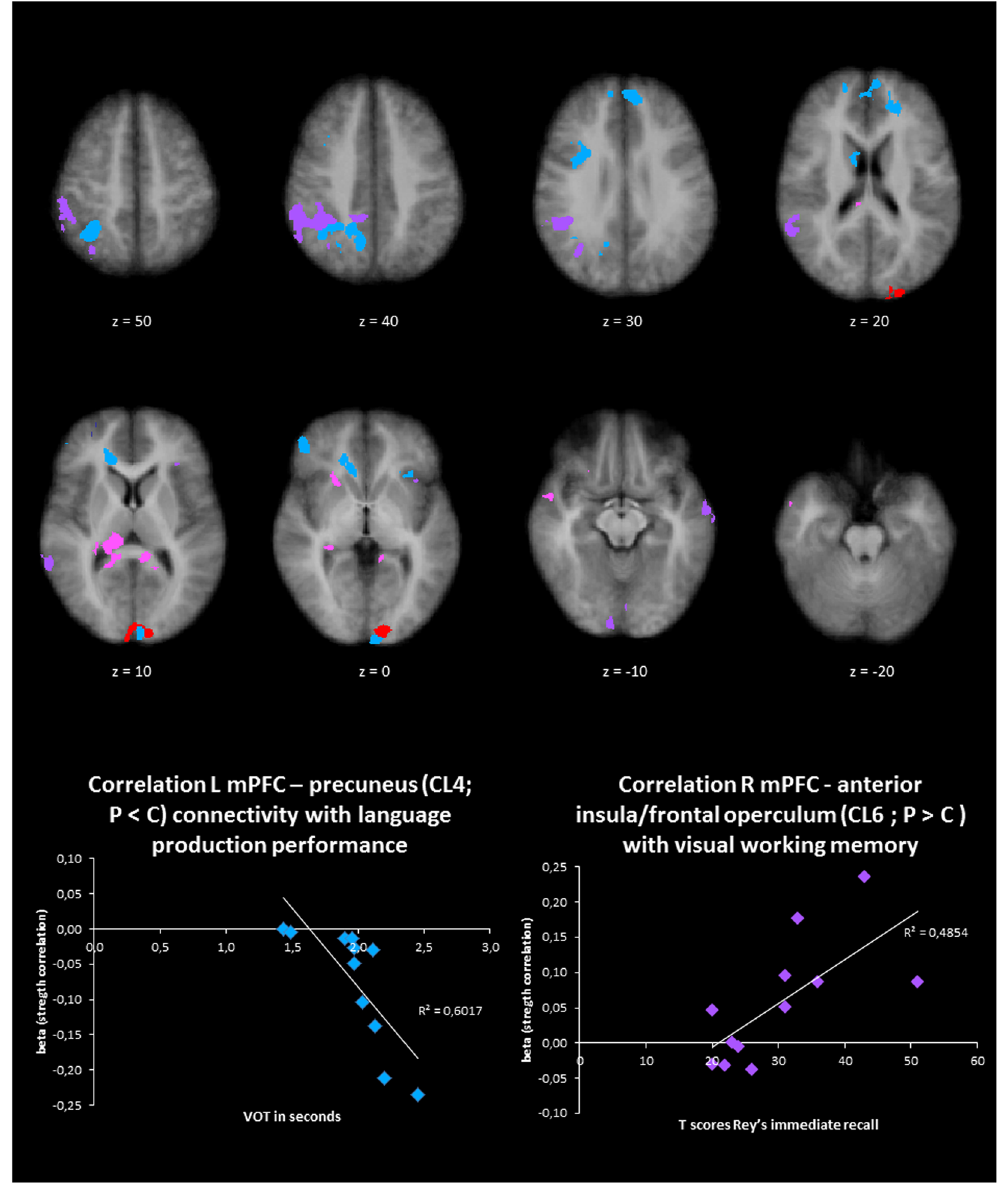
Figure 5. Clusters (VOI) of group differences. Upper part: Overview of clusters (VOI) of group differences, specified per seed (see Table 1). Lower part: Scatterplots of clusters with significant correlations to voice onset times 12 and visuospatial working memory (Rey Immediate Recall T-score 74 ), surviving a Bonferroni